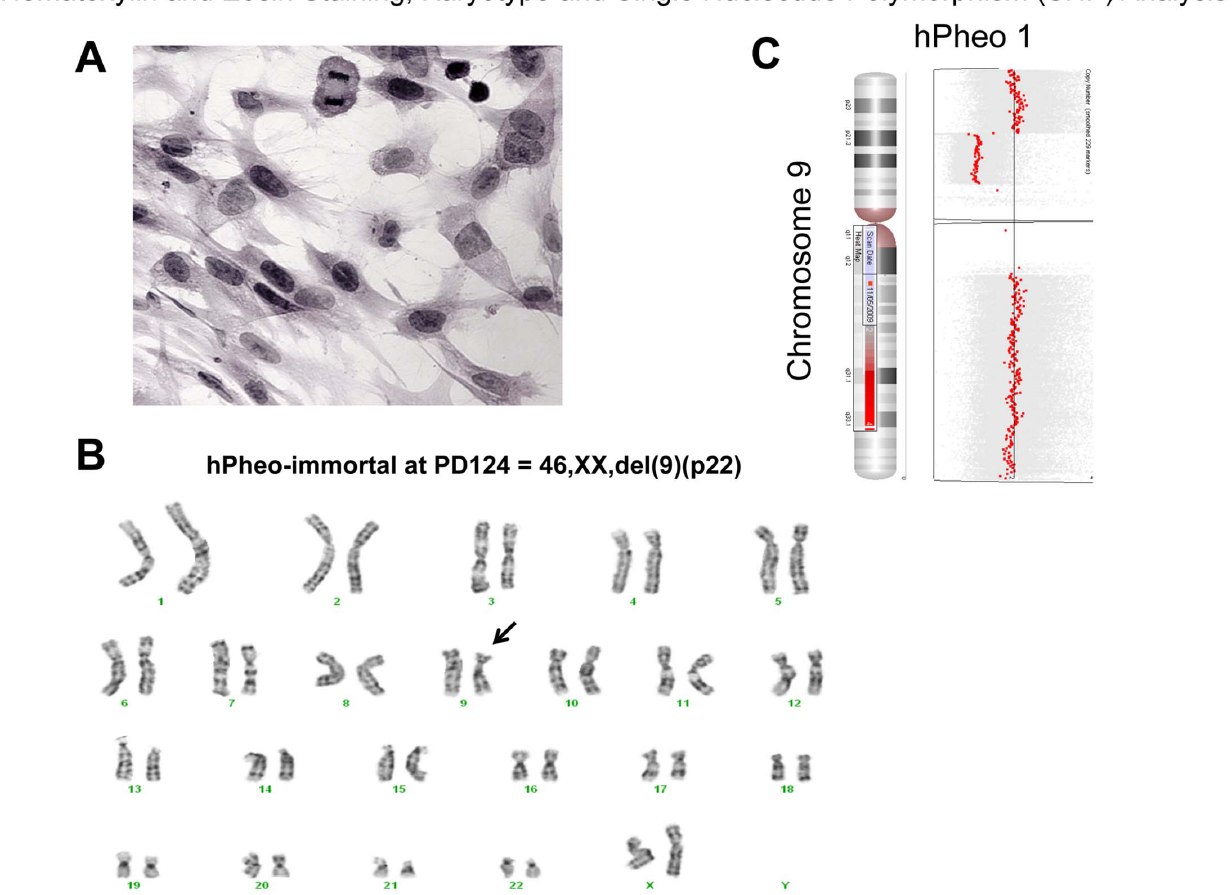
Figure 1. Characterization of hPheo1 cells. A. Hematoxylin and eosin staining shows plump polygonal cells with eosinophilic cytoplasm. B. Karyotypic analysis shows a female diploid pattern with a single cytogenetic abnormality, del9p22 on one chromosome, near its telomeric end (arrow). C. SNP analysis confirms the deletion of 9p, which encompasses the CDKN2A (p16 gene).